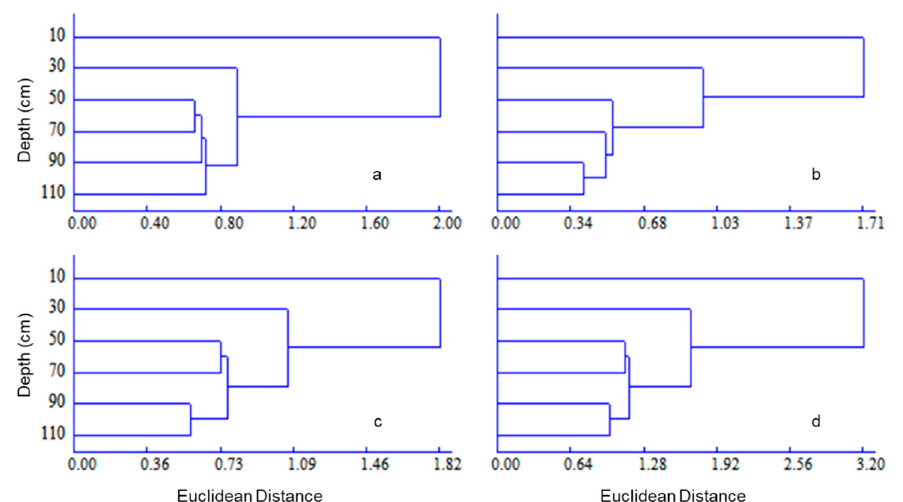
Figure 4. Cluster pedigree of soil moisture variables at different depths in the soil profile during different growing stages of winter wheat: ( a ) sowing to reviving stage; ( b ) returning green and jointing; ( c ) heading to maturity; and ( d ) whole growing season. X-axis is the distance of the variates for soil water content at different layers; y-axis is the different layers in the soil profile.